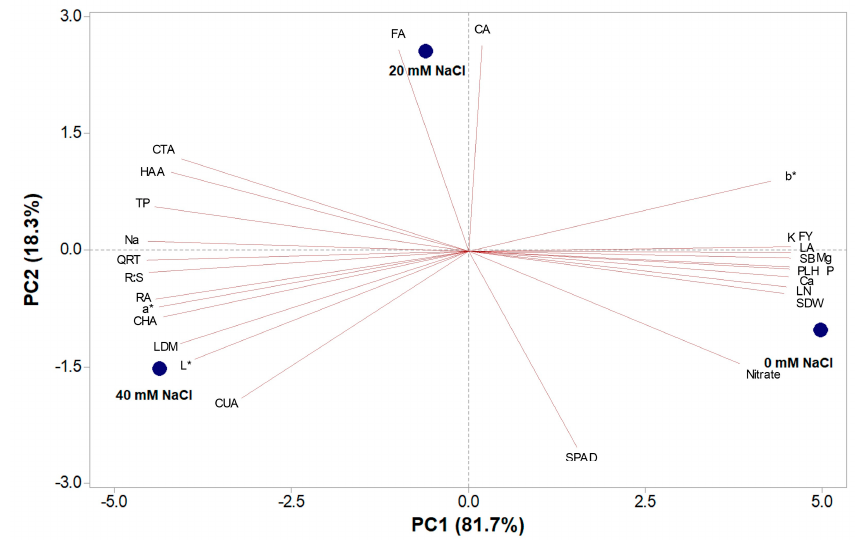
Figure 6. Principal component analysis (PCA) of the basil response to the three experimental conditions, 0, 20, and 40 mM NaCl. Plant height (PLH), leaf number (LN), leaf area (LA), fresh yield (FY), shoot biomass (SB), shoot dry weight (SDW), root-to-shoot ratio (R:S), leaf dry matter (LDM), hydrophilic antioxidant activity (HAA), total polyphenols (TP), caffeic acid (CA), chicoric acid (CHA), caffeoyltartaric acid (CTA), p -coumaric acid (CUA), ferulic acid (FA), quercetin rutinoside acid (QRT), rosmarinic acid (RA).